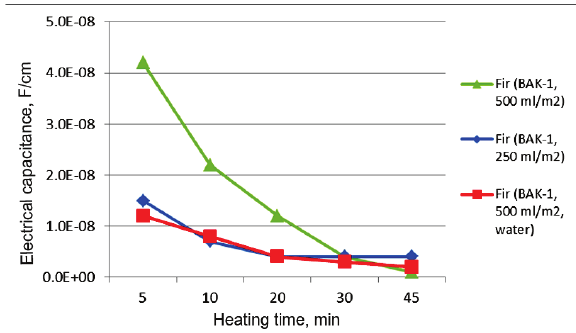
fig. 6. the dependency of the average electrical capacitance on heating time for media 9, 10 and